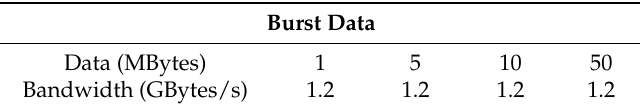
Table 1. Burst data bandwidth (one MC port).